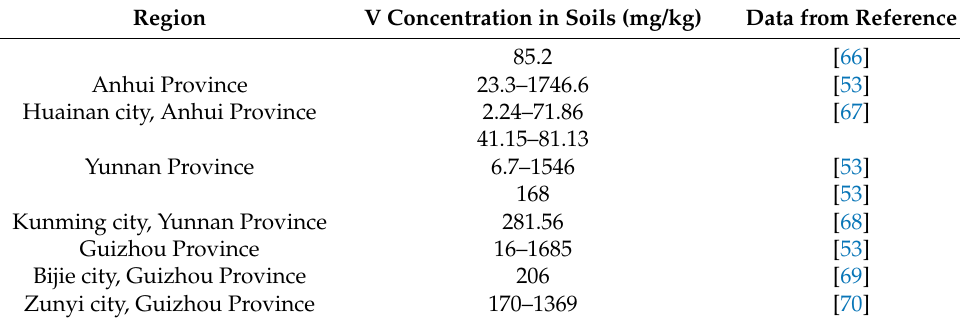
Table 2. Cont. Region V Concentration in Soils (mg/kg) Data from